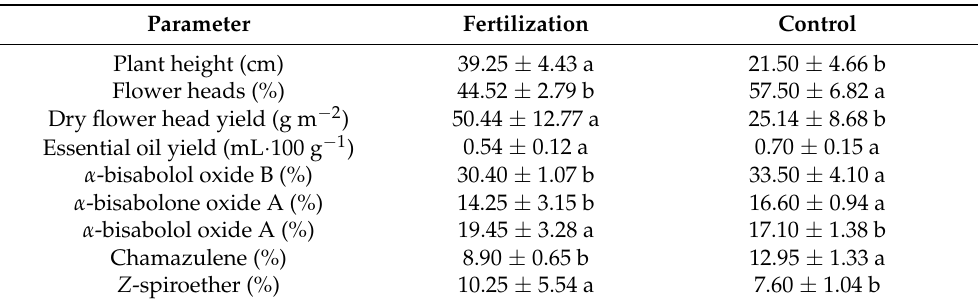
Table 4. Effects of fertilization (across shading treatments) on growth parameters and essential oil main components (mean ± SD) of chamomile.